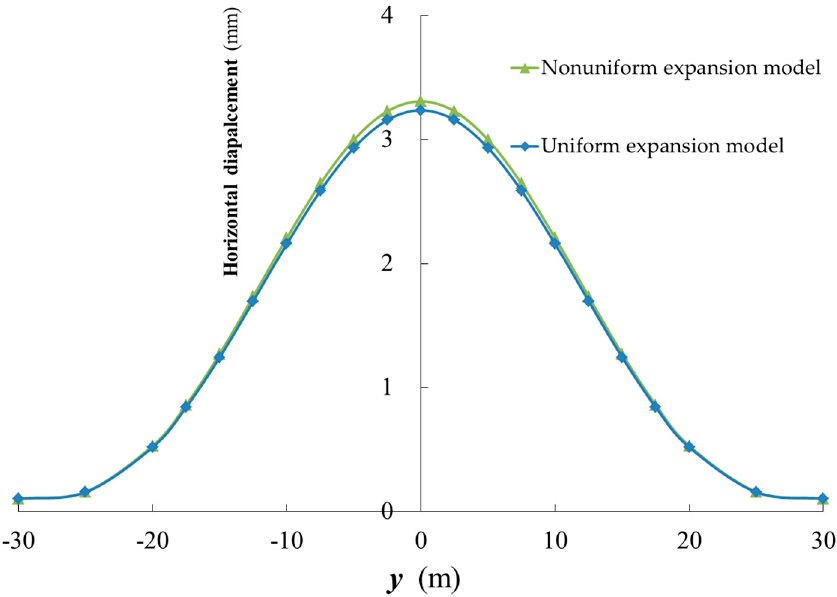
Figure 8. Comparison of the compensated level of horizontal displacement of the tunnel calculated by the nonuniform expansion model with that determined by the uniform expansion model.